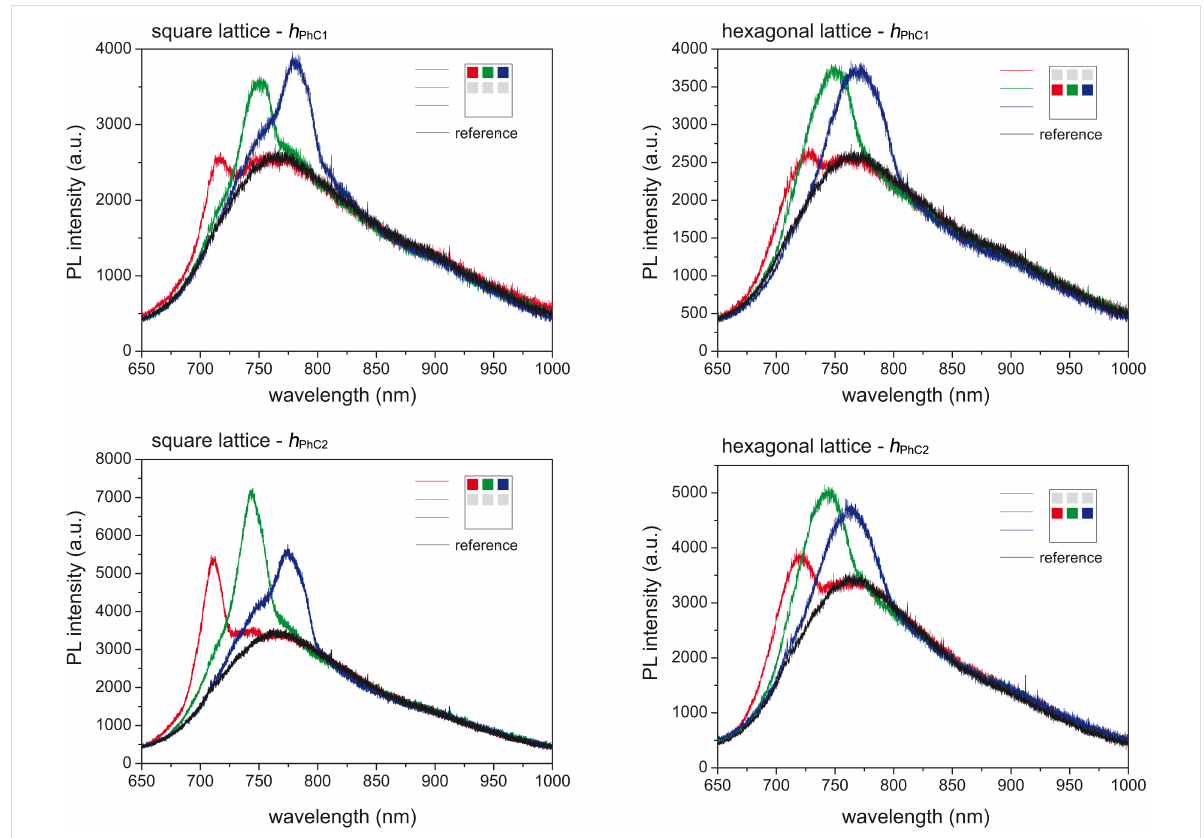
Figure 4: Micro-PL results for the PhCs fabricated on a SiNC-rich SiO 2 layer collected with the objective having NA = 0.12 (collection half angle of 6.9°). PL spectra as a function of the lattice constant of the square (1st column) and hexagonal PhCs (2nd column) with column heights h PhC1 (1st row) and h PhC2 (2nd row). The color code denotes the lattice constant of the PhCs. The corresponding values can be found in Figure 1g.